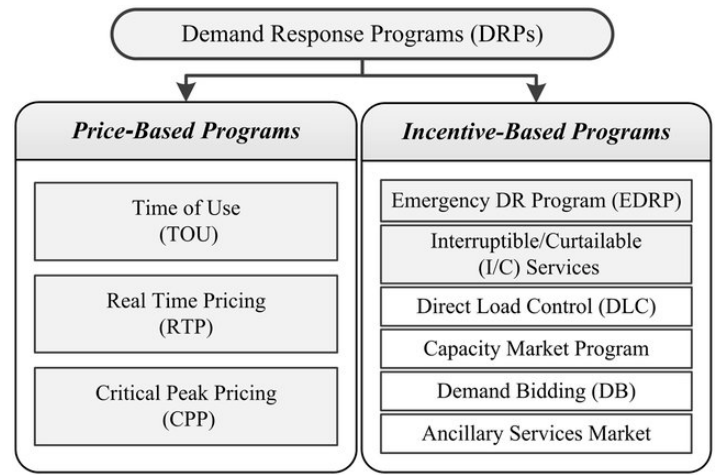
Figure 4. Categorization of Demand Response programs [17].